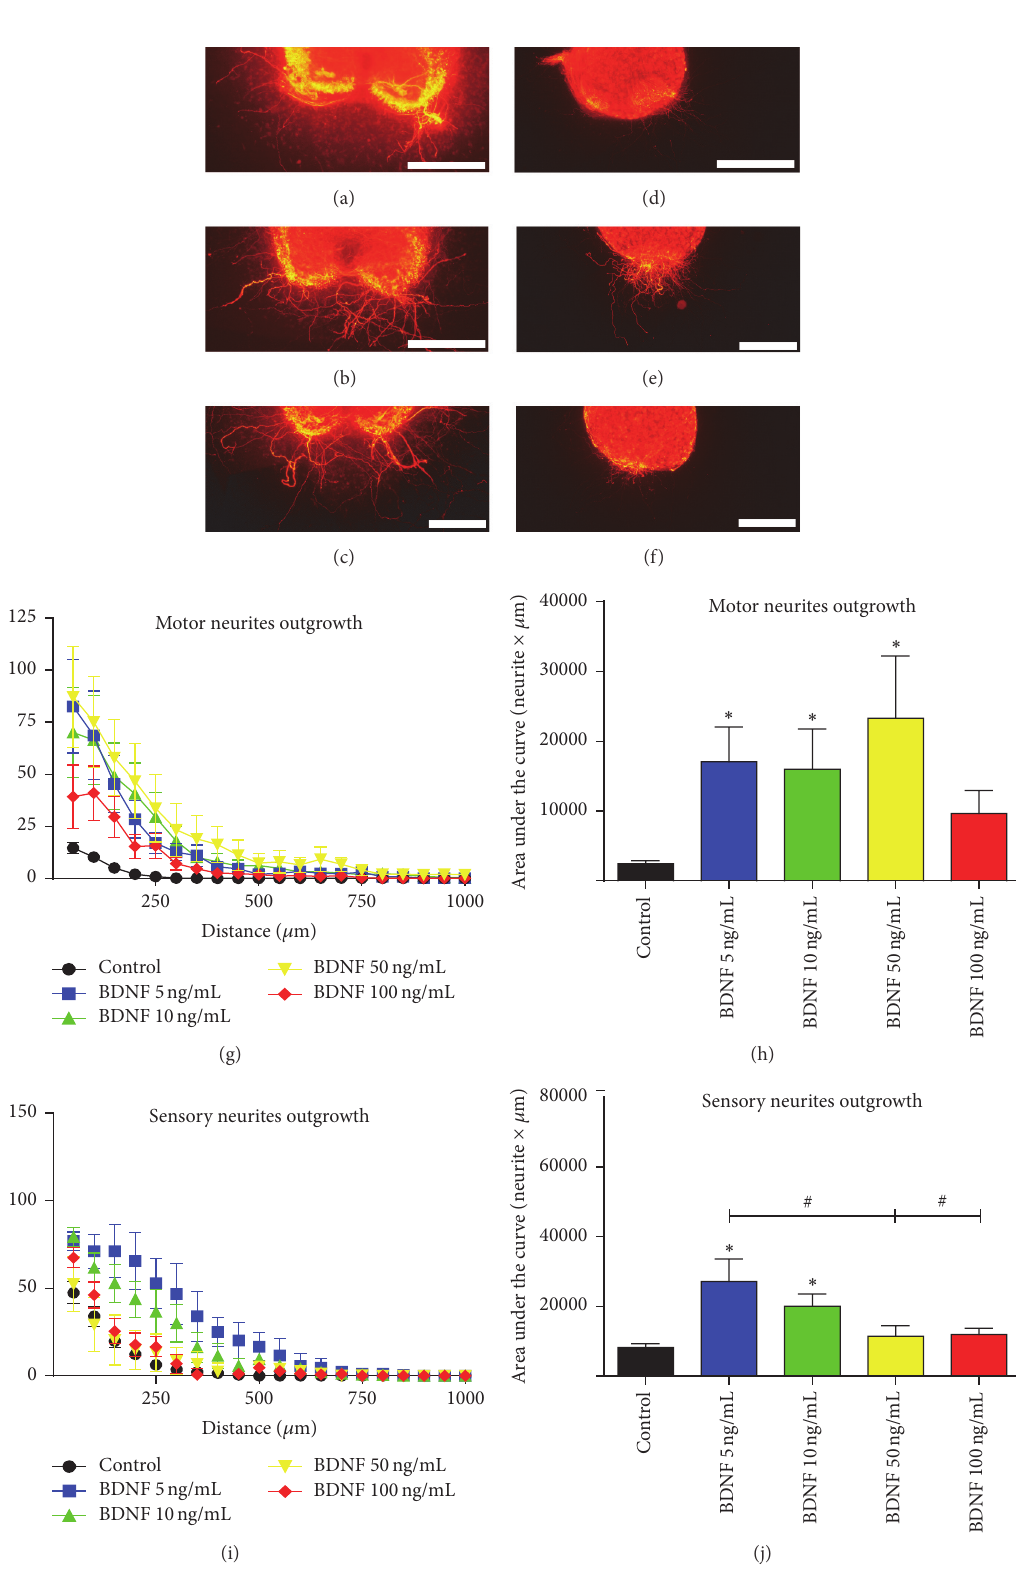
Figure 3: Representative images of RT97 stained neurites from spinal cord slices (a–c) and DRG neurons (d–f) cultured within a 3D collagen matrix alone (a, d) and with addition of 10ng/mL (b, e) and 50 ng/mL of BDNF (c, f). Quantification of the number of neurites grown at increasing distance from the cord slices (g) and from DRG body (i) after the addition of different doses of BDNF. Plots of the quantified area under each curve from (g) and (i) graphs for motor (h) or sensory neurite outgrowth (j). Data expressed as mean ± SEM. ∗ 𝑝 < 0.05 versus control; # 𝑝 < 0.05 . Scale bar: 200 𝜇 m